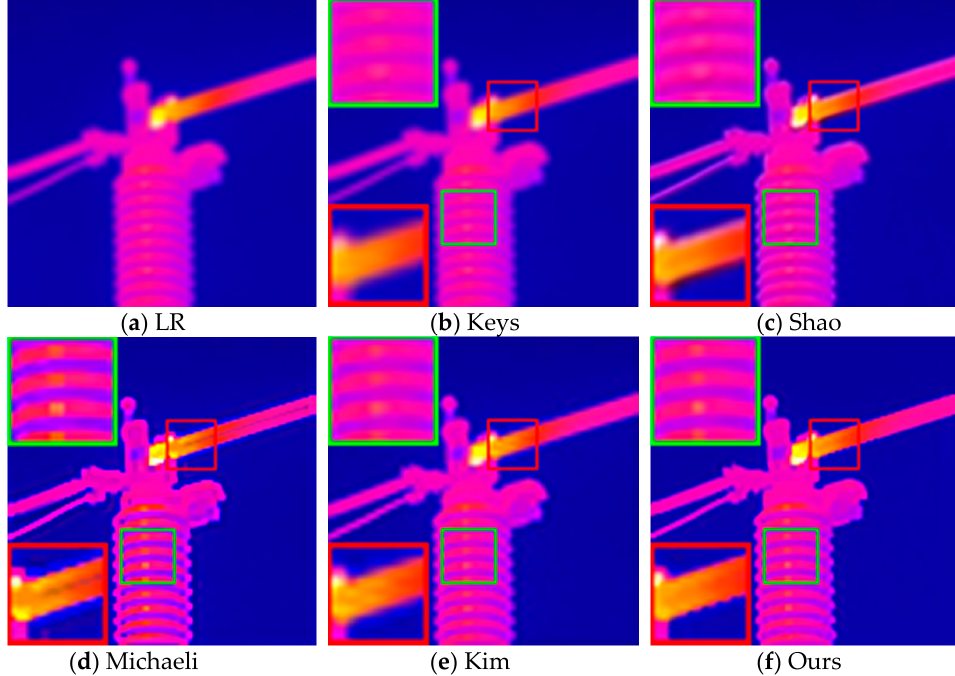
Figure 4. Reconstruction results of different methods when using 5 × 5 Gaussian blur kernel: ( a ) synthetic infrared image; ( b ) reconstruction results using the method in [35] (PSNR = 24.646dB; SSIM = 0.903; AG = 21.612; IE = 5.881); ( c ) reconstruction results using the method in [19] (PSNR = 25.747dB; SSIM = 0.963; AG = 27.710; IE = 5.903); ( d ) reconstruction results using the method in [17] (PSNR = 26.238dB; SSIM = 0.958; AG = 30.281; IE = 5.928); ( e ) reconstruction results using the method in [21] (PSNR = 25.321dB; SSIM = 0.955; AG = 29.591; IE = 6.014); ( f ) reconstruction results using our method (PSNR = 28.803dB; SSIM = 0.968; AG = 32.030; IE = 6.082).